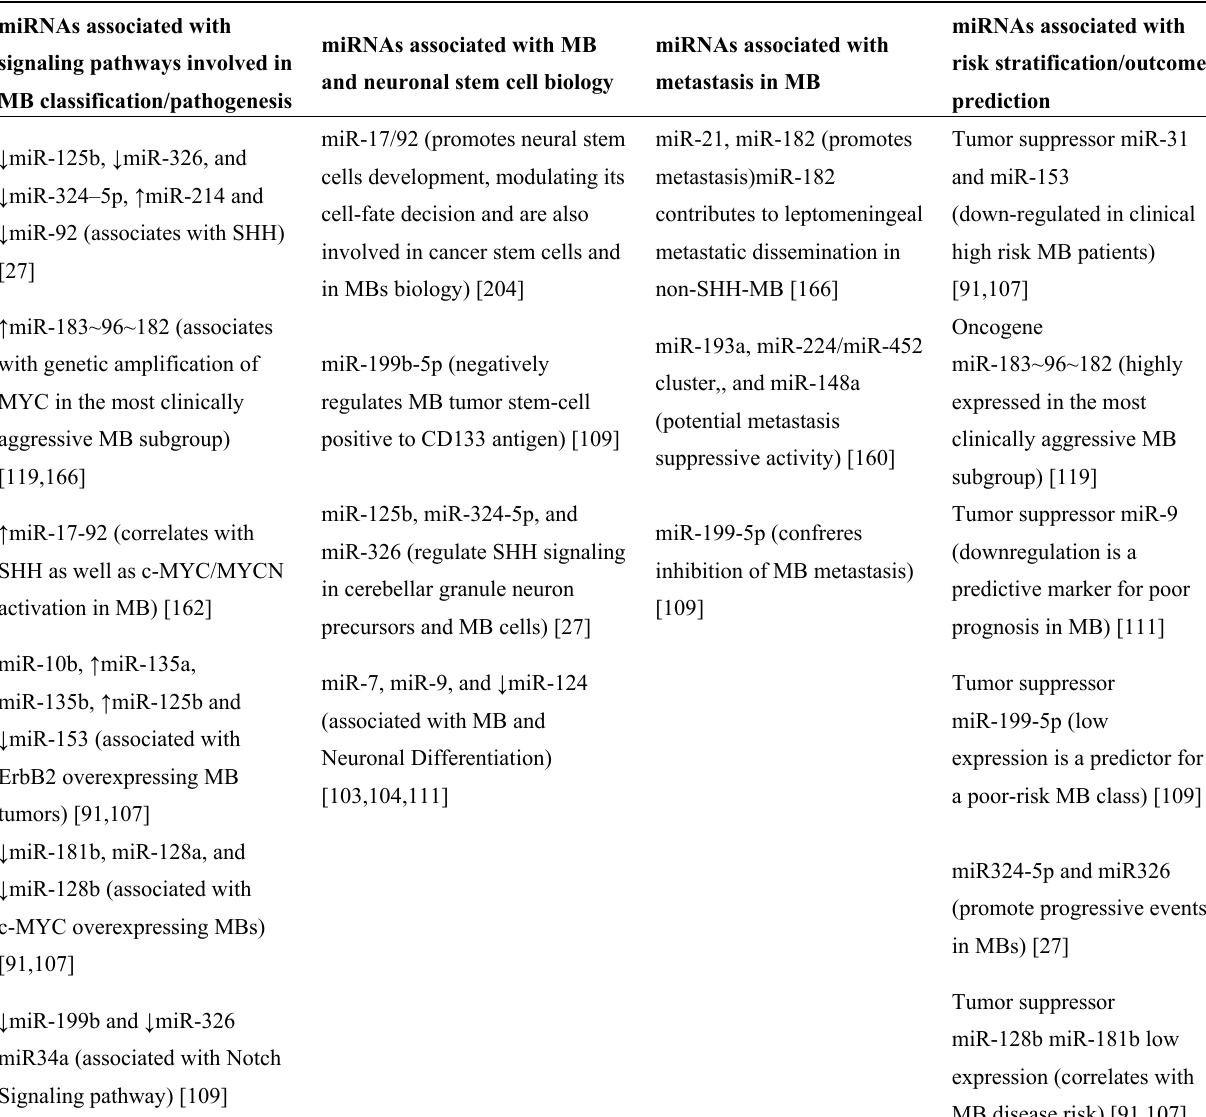
Table 3. Biological and clinical relevance of miRNAs in